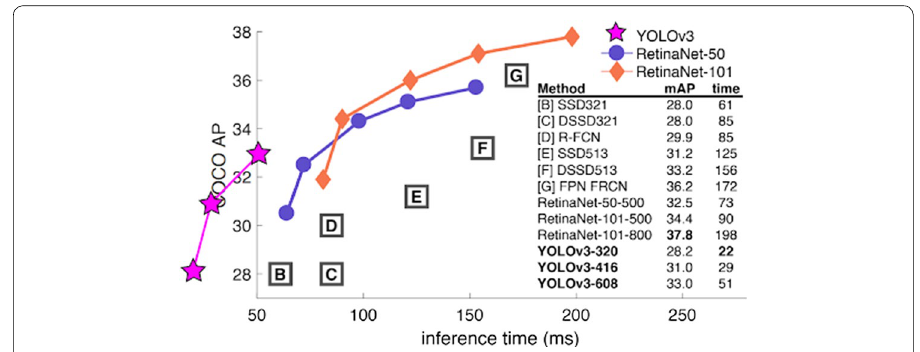
Fig. 1 Performance tests of neural networks on COCO